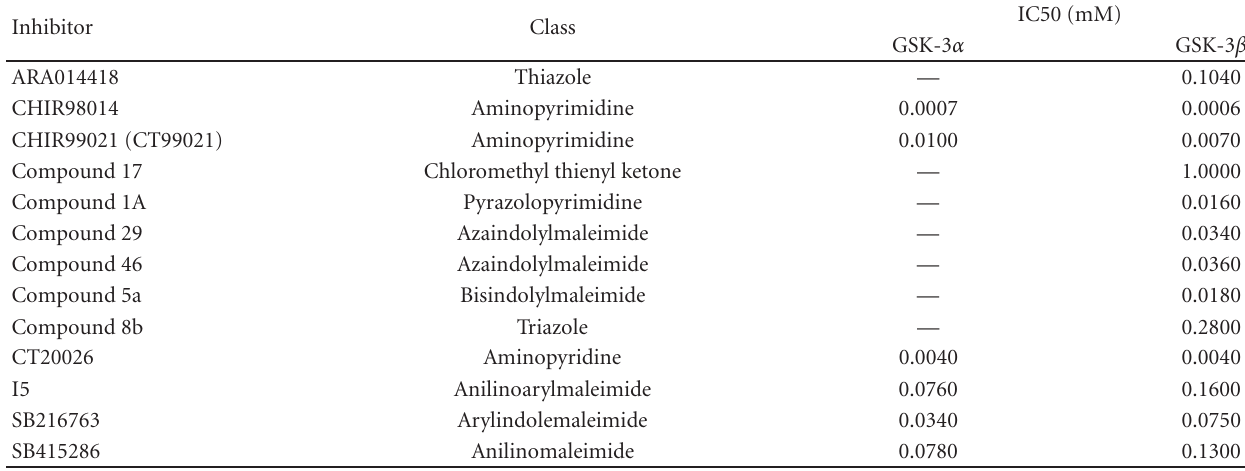
Table 1: New GSK-3 β inhibitors under